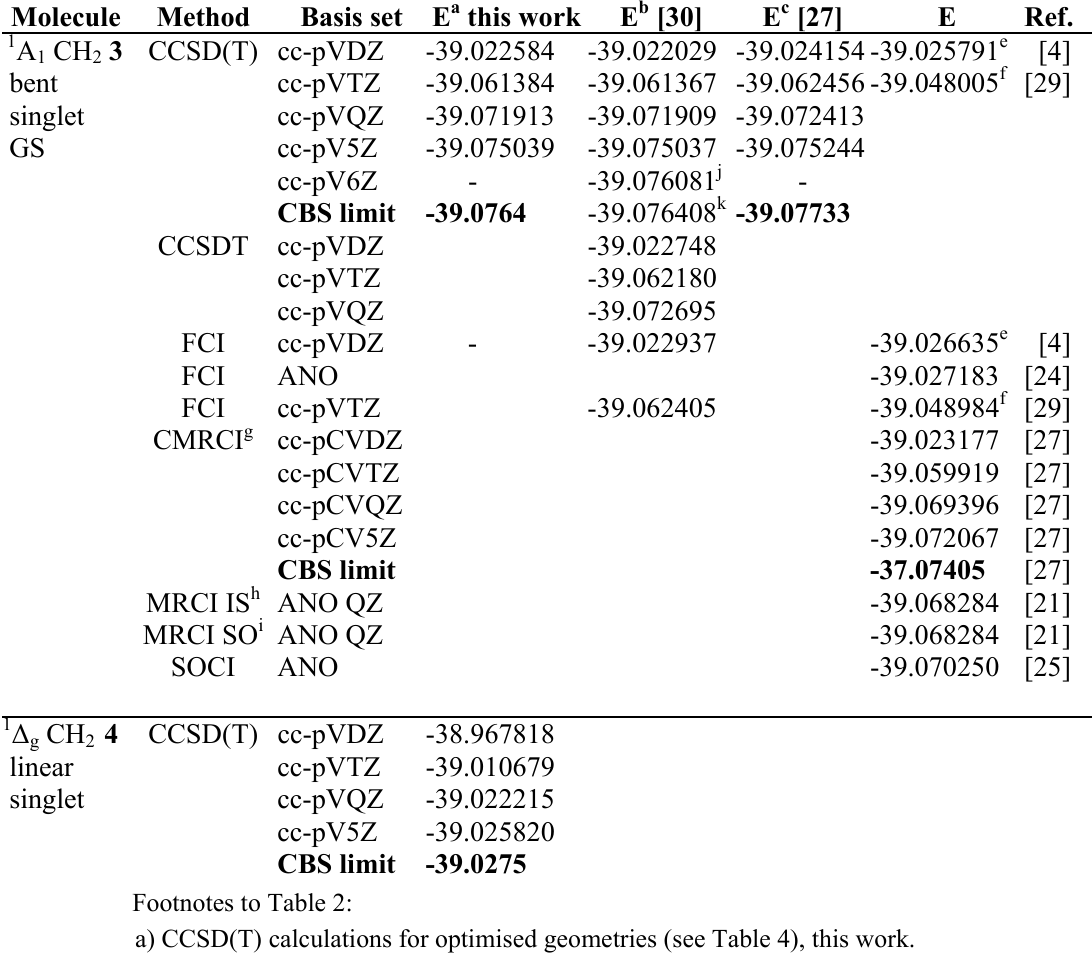
Table 2. Post-HF frozen-core calculations of total energies [Hartree] with Dunning basis sets for singlet methylenes 3 and 4. Own CCSD(T) calculations with exponential TQ5 CBS limits via eqn. 1 and literature data for different